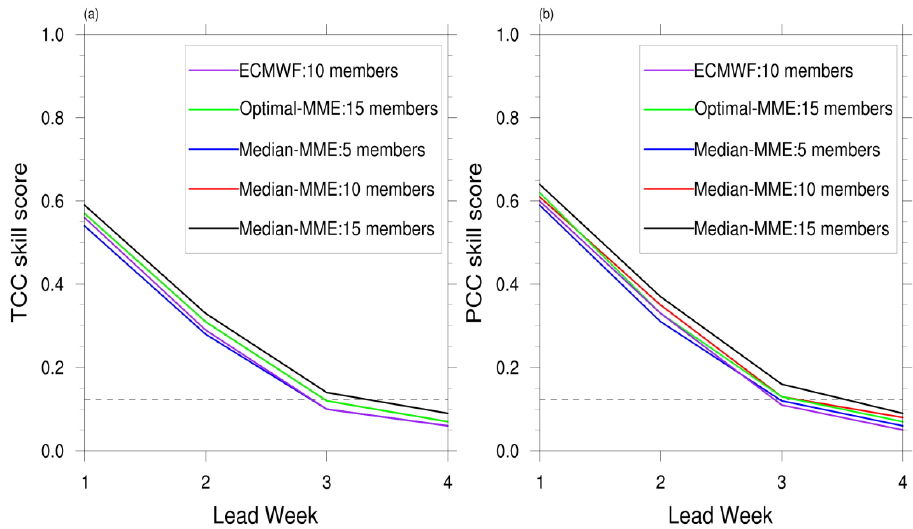
Figure 5. Spatial average of the TCC ( a ) and time average of the PCC ( b ); 5-member, 10-member, 15-member median MMEs, 15-member optimal MME, and 10-member ECMWF are, respectively, plotted in blue, red, black, green and purple. The dashed black line represents the 95% significance threshold.